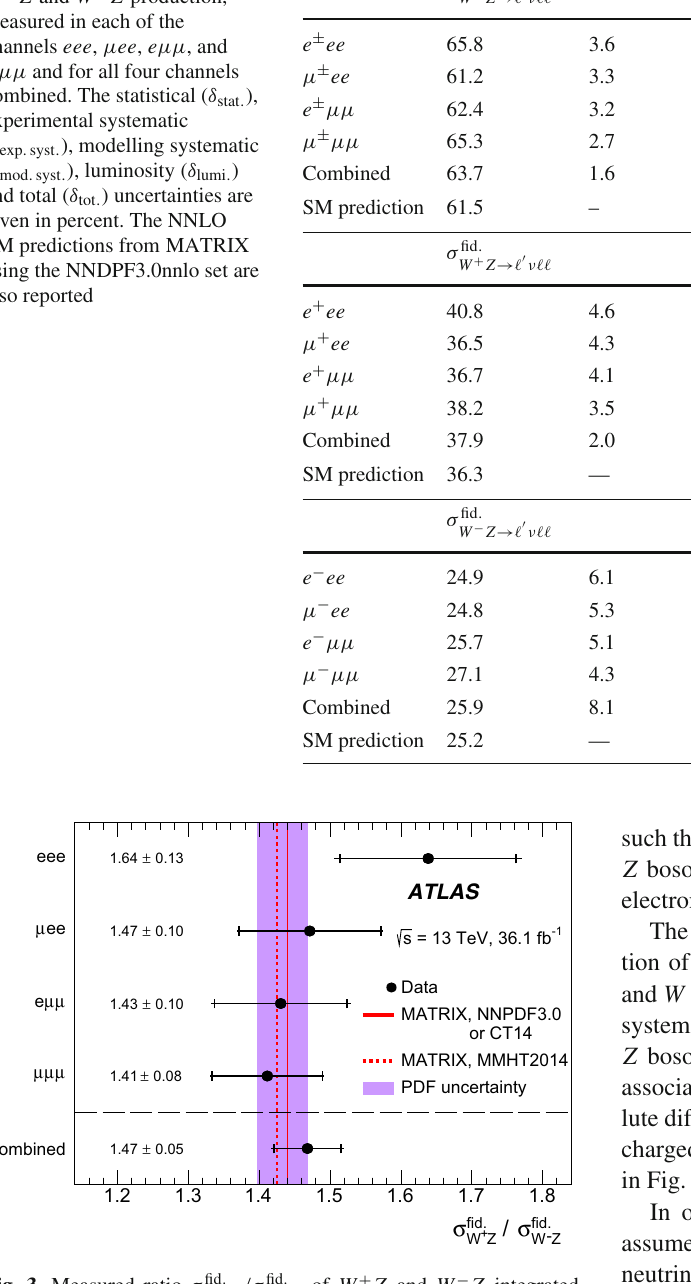
/σ fid . Fig. 3 Measured ratio σ fid . of W + Z and W − Z integrated W + Z W − Z cross sections in the fiducial phase space in each of the four channels andfortheircombination.Theerrorbarsonthedatapointsrepresentthe total uncertainties, which are dominated by the statistical uncertainties. The NNLO SM predictions from MATRIX using the NNPDF3.0nnlo or CT14 PDF sets are equal and represented as a single red line. The shaded violet band represents the effect of PDF uncertainties estimated using the Powheg+Pythia NLO calculation using the CT10 eigenvec- tors and the envelope of the differences between the CT10 and CT14, MMHT2014 and NNPDF 3.0nnlo PDF sets. The MATRIX prediction using the MMHT2014 PDF set is also displayed as the dashed-red